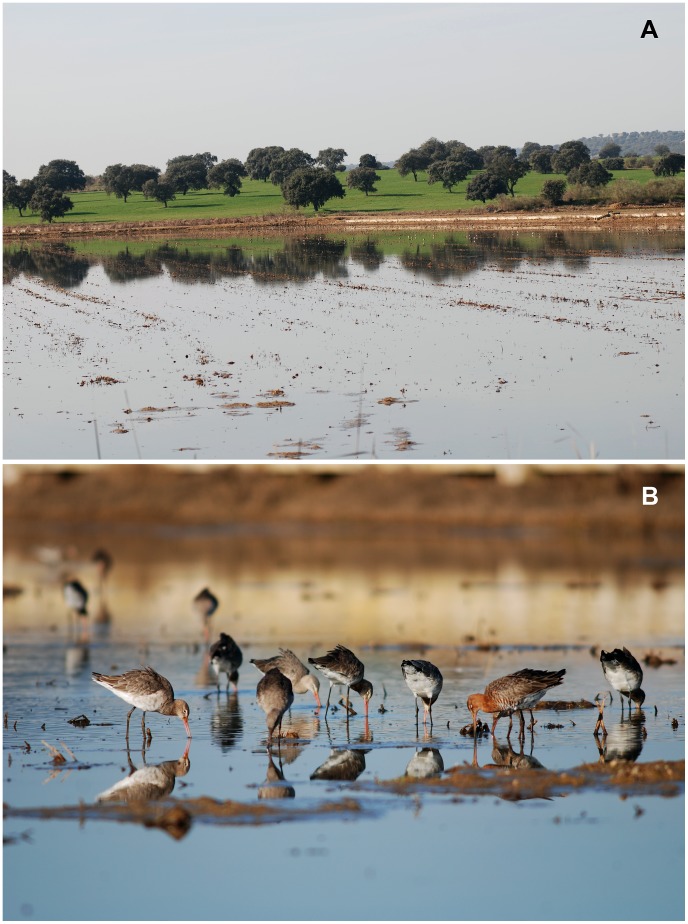
Large numbers of shorebirds consistently use temperate inland freshwater habitats during winter and migration.
A Shorebirds in inland freshwater wetlands, such as rice fields in Extremadura, often experience favourable feeding conditions (absence of tidally-induced food restrictions, low salinity of prey and drinking water, and less windy microclimates) which could contribute to reduce the levels of energy expenditure, and hence BMR. B Black-tailed godwits feeding on spilled rice seeds in Extremadura’s rice fields.